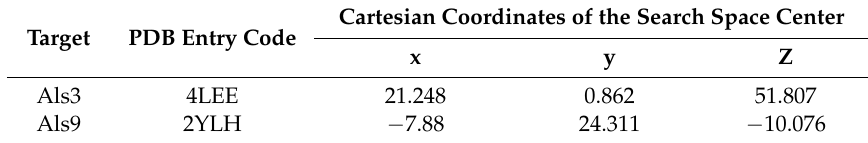
Table 9. Target macromolecular structures retrieved from Protein Data Bank (PDB).